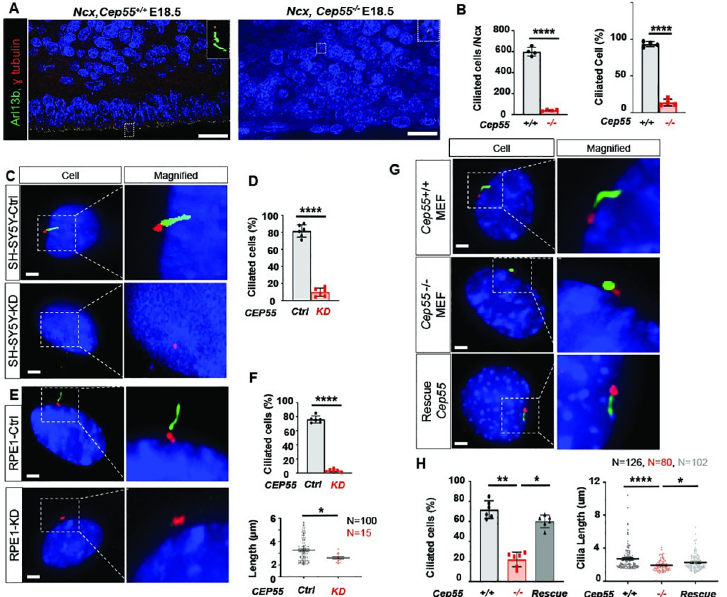
Fig 4. Cep55 is localized to basal body of cilia and regulates ciliogenesis. (A) Super-resolution microscopy of Cep55 +/+ and Cep55 -/- mouse neocortex at E18.5 immunostained for cilia (Arl13b), basal body ( γ -tubulin), and DAPI, scale = 10 μ m. (B) Percent of cilia-positive cells in Ncx at E18.5, p < 0.0001. (C-H) Representative images showing cilia (Arl13b), basal body ( γ -tubulin), Cep55 (yellow), and DAPI (blue), Scale = 5 μ m. (C) Representative image of cilia and basal body in control (upper) and CEP55 knockdown (lower) in SH-SY5Y cells. (D) Percentage of ciliated cells in Ctrl and CEP55 knockdown SH-SY5Y, p < 0.0001. (E) Cilia, basal body, and CEP55 staining in RPE-1 cells transfected with a control lentiviral vector (Ctrl) (upper), RPE-1 cells with lentiviral knockdown of CEP55 (lower). (F) Percentage of ciliated RPE-1 cells with or without CEP55 knockdown (upper, P < 0.0001), Scatter plot showing cilia length in control RPE-1 cells or with CEP55 knockdown (lower, p < 0.0211). (G) Representative image of cilia, basal body and Cep55 in Cep55 +/+ (Wt) MEFs (upper), Cep55 -/- (KO) MEFs (middle), Cep55 -/- MEFs with ectopic expression of Flag-CEP55 (Rescue) (lower). (H) Percentage of ciliated cells in Cep55 +/+ , Cep55 -/- and Cep55 -/- , p < 0.0022; cells reconstituted with a human CEP55 construct (rescue, p < 0.0303). Data represent mean ± SD of 300 cells per genotype (left); scatter plot showing cilia length ( μ m) in Cep55 +/+ , Cep55 -/- , p < 0.0001 and CEP55-reconstituted MEFs, p < 0.0101. Data were measured in duplicate across two independent experiments (right). For all calculations, one-way ANOVA (Kruskal– Wallis test) performed, � p < 0.05, �� p < 0.01, ��� p < 0.001, ���� p < 0.0001).